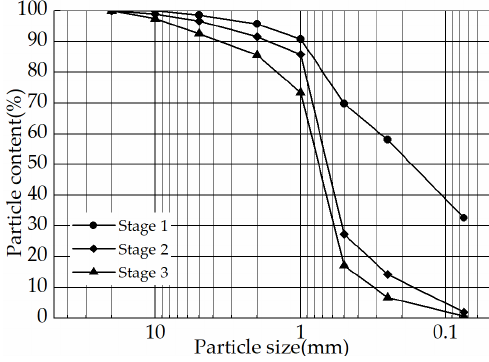
Figure 7. Seepage test results of group 2.